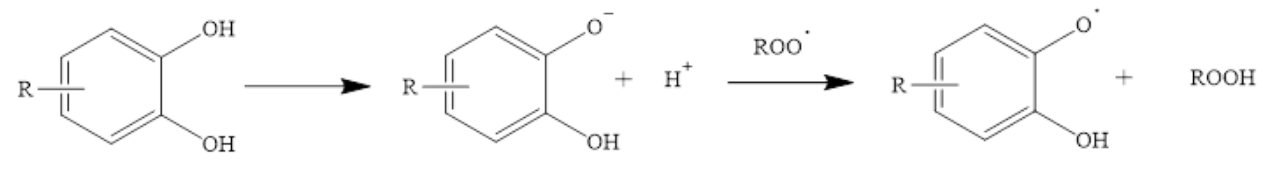
Figure 5. Phenolic acid derivative neutralizing a free radical via SPLET [53].